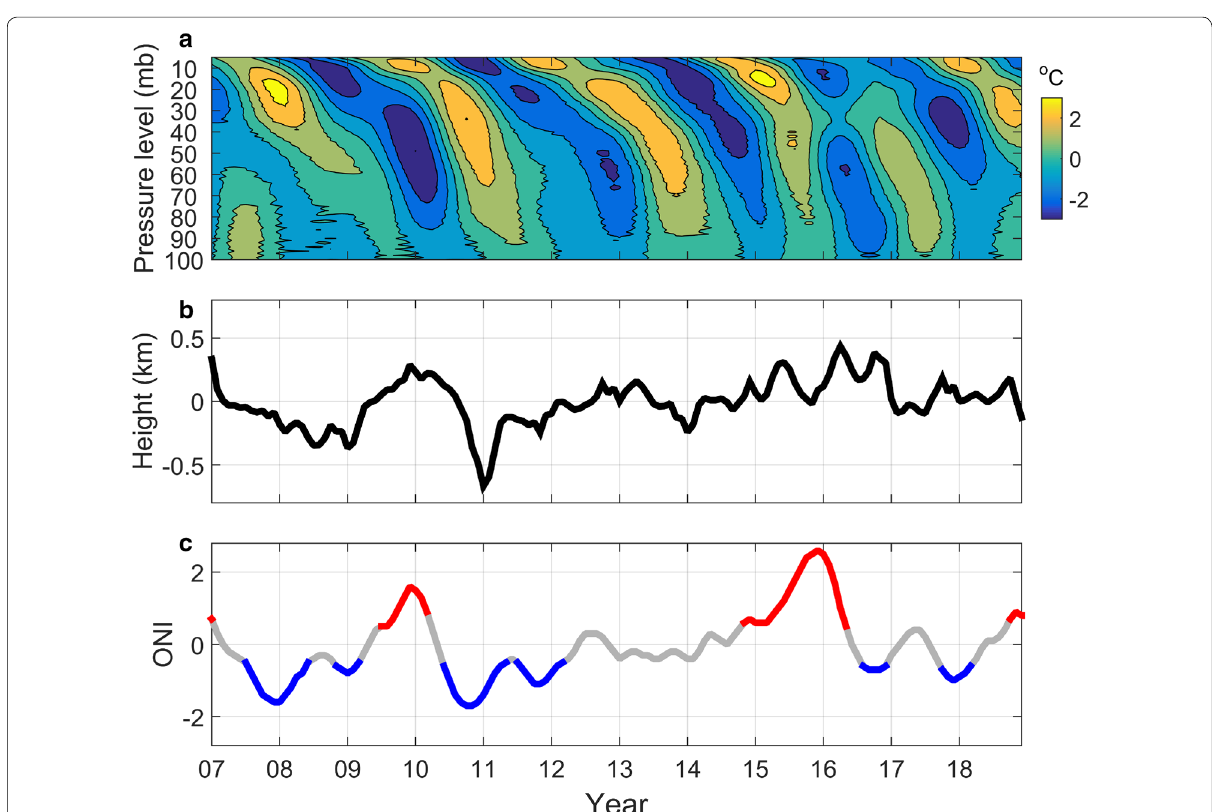
Fig. 2 a Quasi‑biennial oscillation (QBO) and b tropopause height respond to El Niño‑Southern Oscillation (ENSO) observed by the FORMOSAT‑3/ COSMIC (F3/C) radio occultation (RO) technique. A band‑pass filter with the cutoff period ranging from 18 to 34 months is applied to extract the QBO component from the RO temperature averaged within 5° N–5° S at each pressure level. b The departure of tropopause height from its mean annual cycle. The monthly tropopause height is averaged over the Niño 3.4 area (5° N–5° S, 120°–170° W). c Red and blue (exceeding the threshold of 0.5 °C) on the Oceanic Niño Index (ONI) indicates the ENSO warm and cold phases, ±